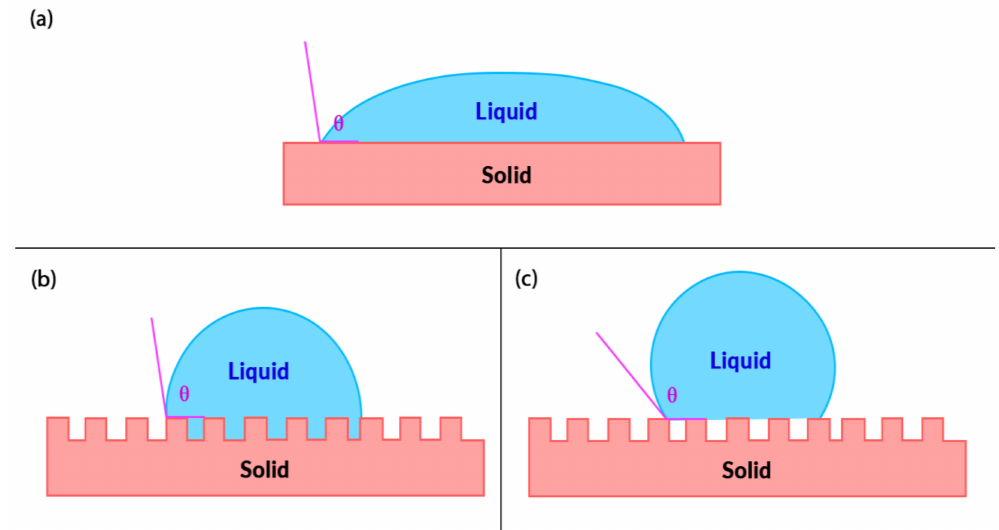
Figure 6. Schematic representation of different wetting models: ( a ) Young’s model, which describes the basic wetting phenomenon on an ideal, homogenous surface; ( b ) Wenzel’s model, which describes wetting phenomenon that considers surface roughness; ( c ) Cassie–Baxter’s model, which is a more complex model that describes wetting phenomenon on a heterogenous